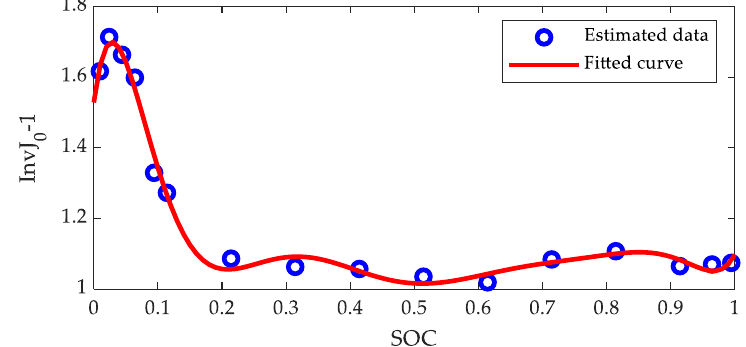
Figure 13. Variation curve of dimensionless charge exchange current invJ 0 with SOC.